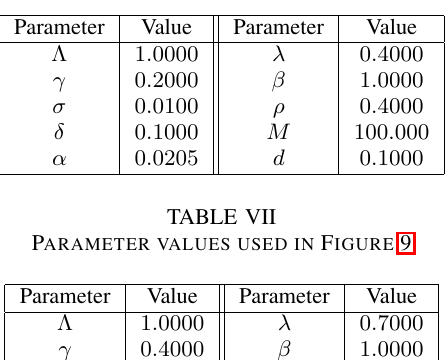
P ARAMETER VALUES USED IN F IGURE